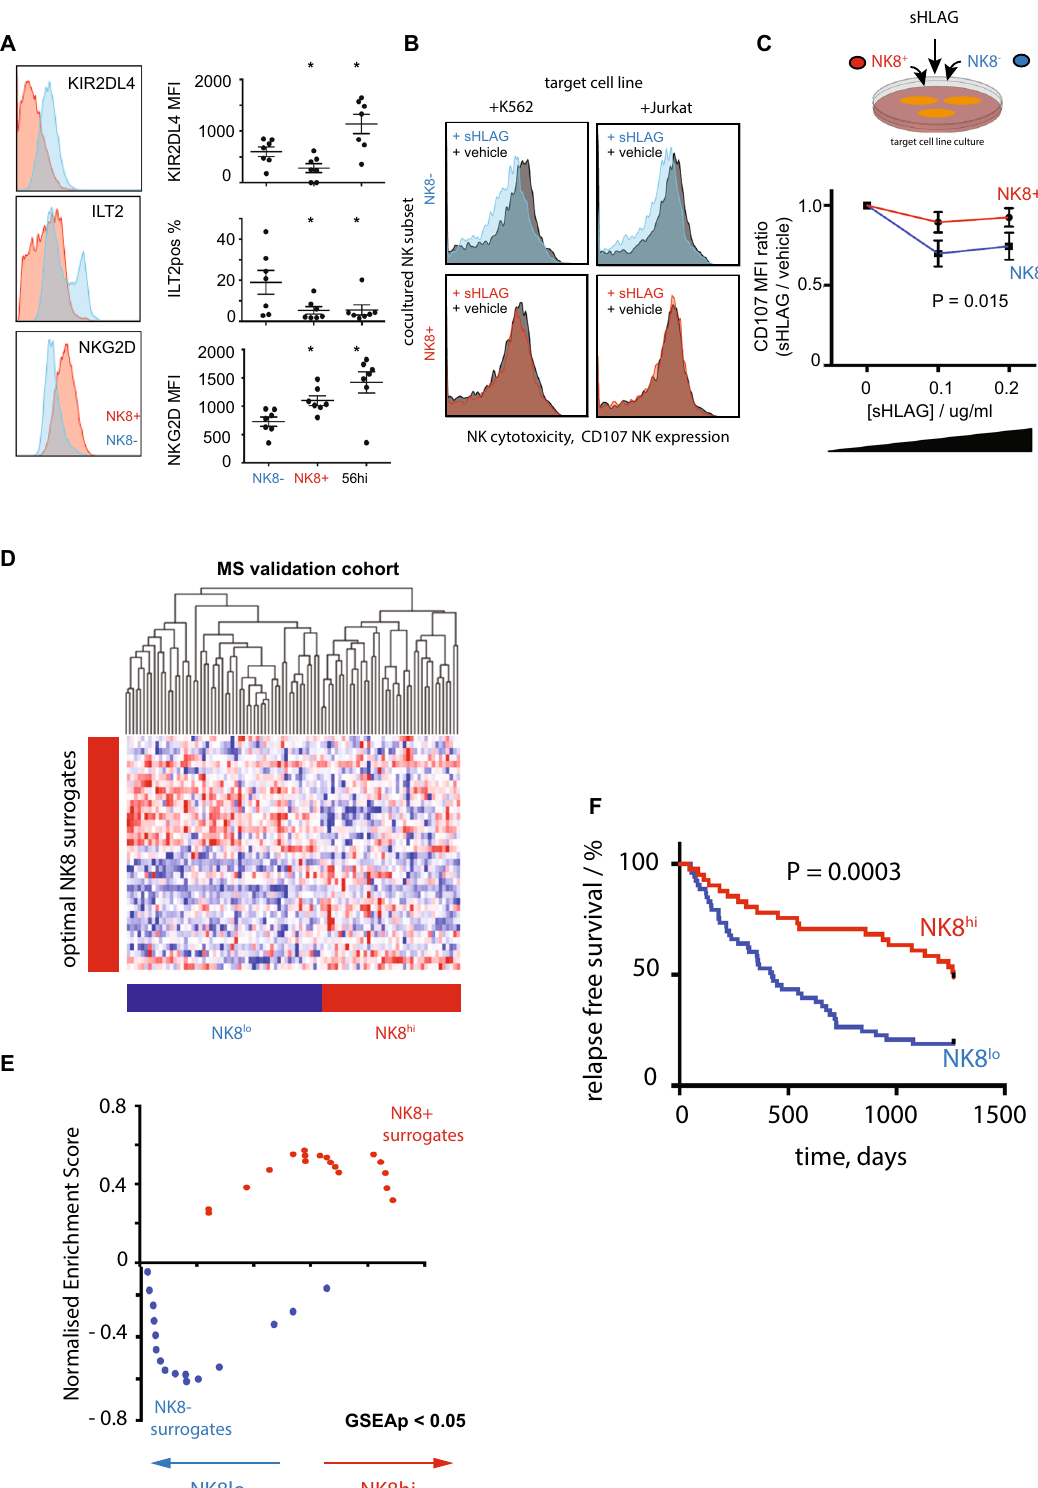
Fig. 2). To generate a transcriptional signature speci fi c to NK8 + cells (Supplementary Data 3), 50 ml of peripheral whole blood was collected from fi ve healthy volunteers, from which PBMC were isolated by centrifugation over Histopaque (Invitrogen). NK8 + (CD3 − CD56 + CD8 + ), NK8 − (CD3 − CD56 + CD8 − ) and CD3 + 8 + T cells were isolated by fl ow sorting following staining with anti-CD56 (Clone